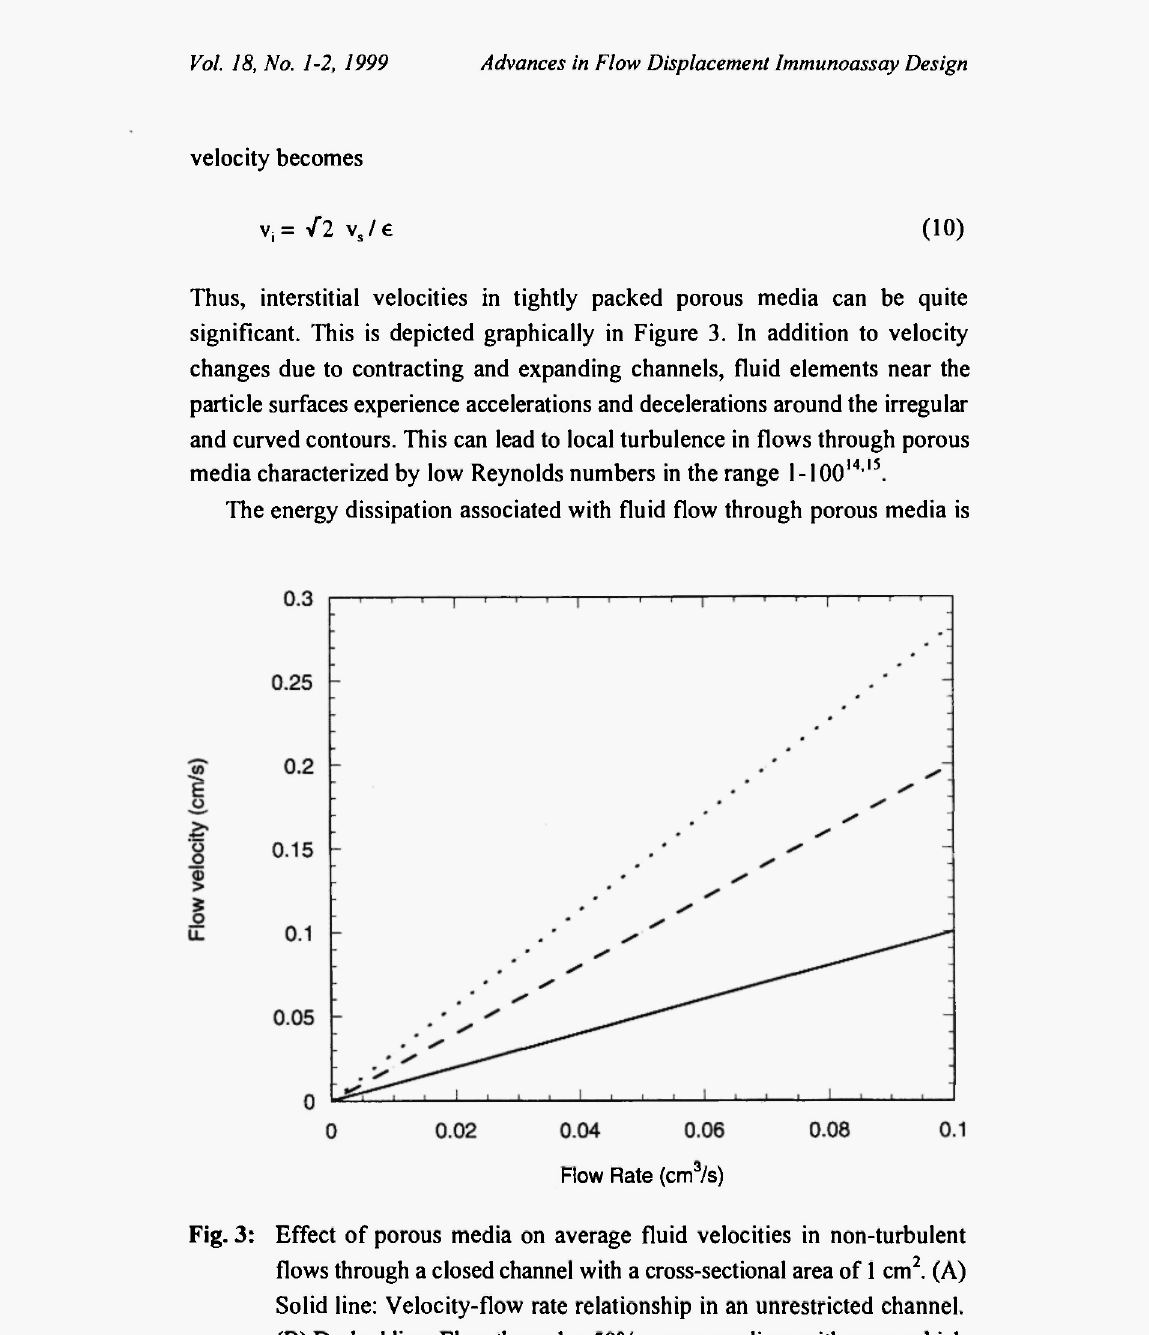
Fig. 3: Effect of porous media on average fluid velocities in non-turbulent flows through a closed channel with a cross-sectional area of 1 cm 2 . (A) Solid line: Velocity-flow rate relationship in an unrestricted channel. (B) Dashed line: Flow through a 50% porous medium with pores which span the medium parallel to the direction of flow. (C) Dotted line: Estimated velocity in a 50% porous medium with zigzag channels as would be found in a bead-packed